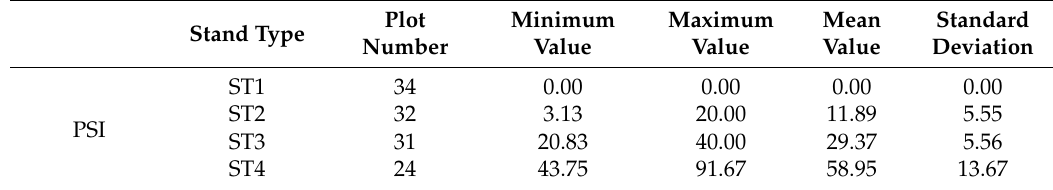
Table 2. The distribution of PSI in four stand